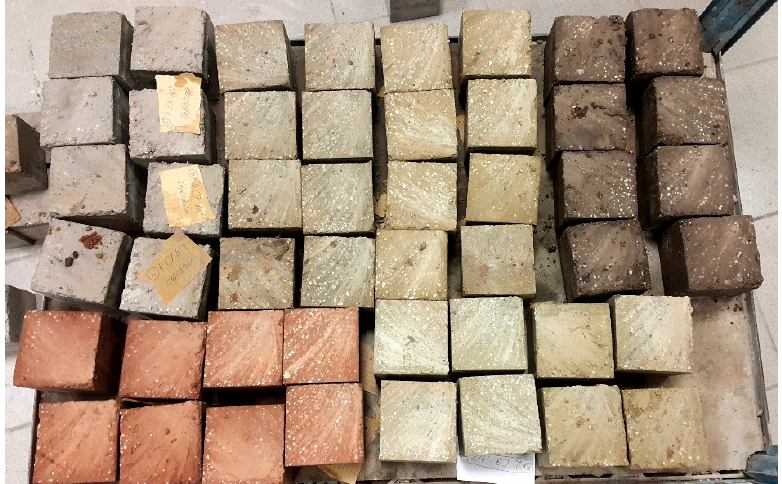
Figure 6. Part of the CSRE samples on which the compressive strength tests were